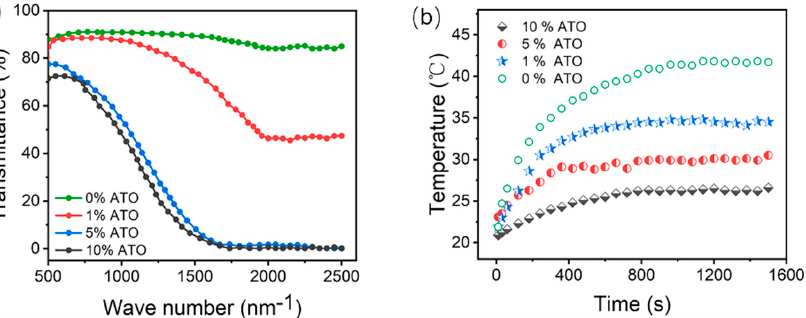
Figure 11. ( a ) The transmittance between 500 and 2500 band; ( b ) Thermal insulation curves of CPUSi/ATO composite coatings with different ATO contents.